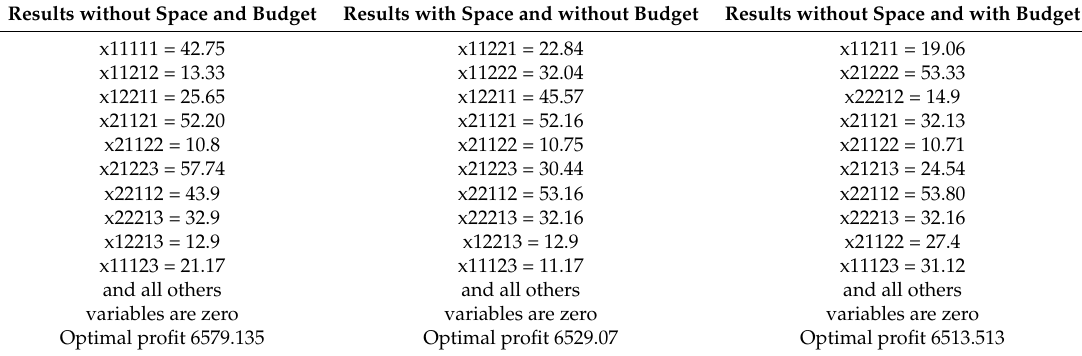
Table 8. Optimum results for existence of different constraints (Expected Value Technique) by